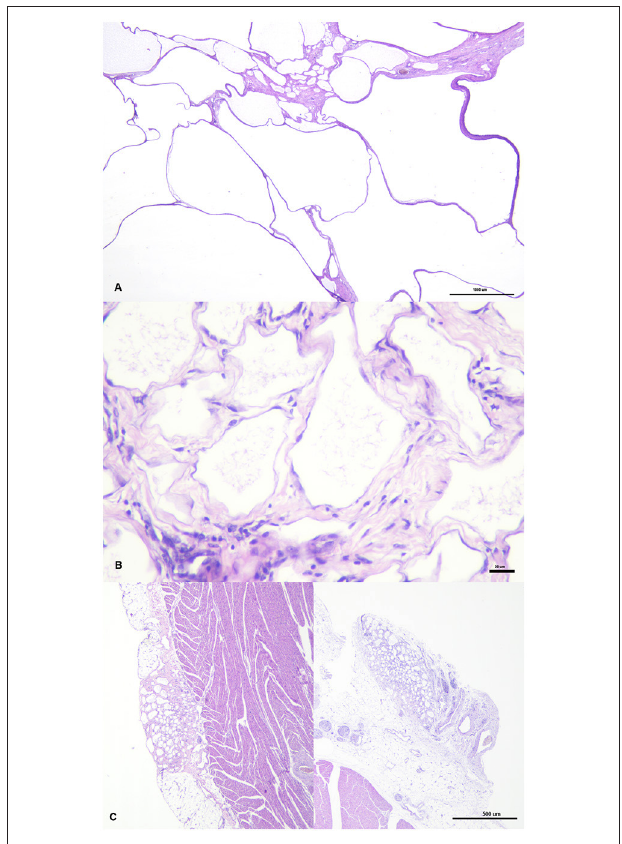
FIGURE 2 | Cystic structures have different size and are separated by septa of variable thickness (A) . They are lined by endothelial cells surrounded by fibrovascular tissue, where fusiform cells and occasional aggregates of lymphocytes and plasma cells are seen (B) . Two foci or lymphatic vessel proliferation, arising from the epicardium, simultaneously at two different point can be seen on the left and right pictures (C) .